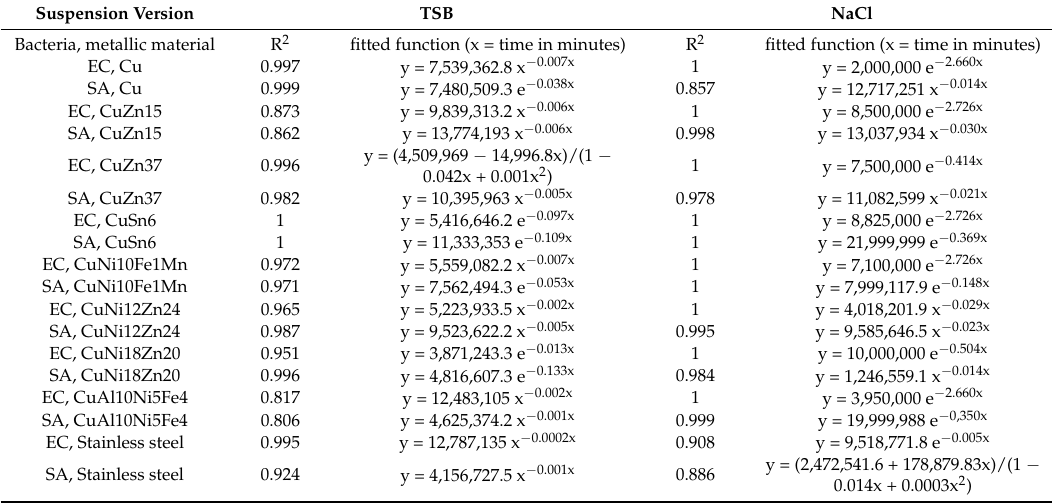
Table 2. Formulas of fitted